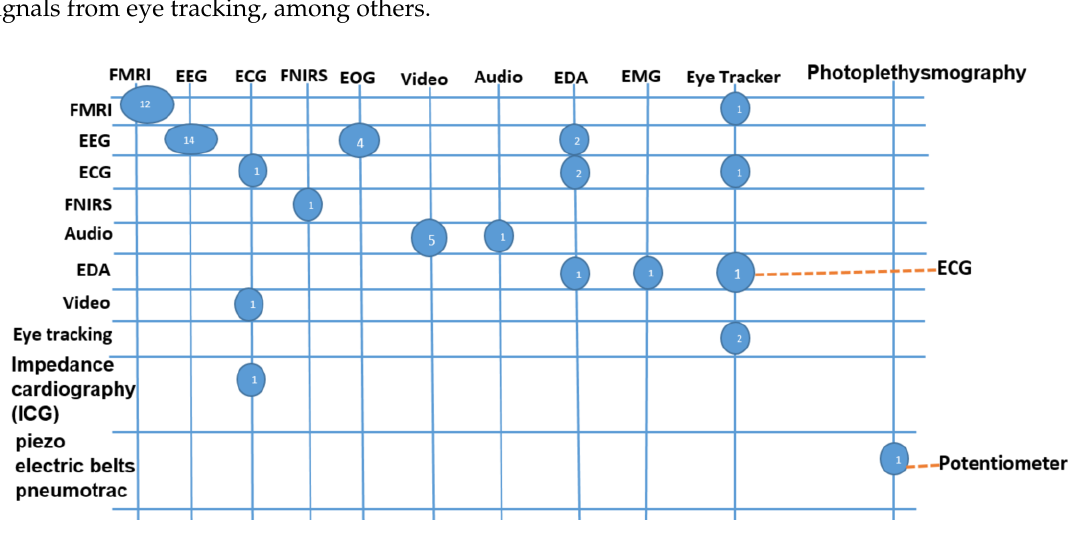
Figure 6. Bubble plot of psychophysiological signal combinations in studies assessing trust using psychophysiological